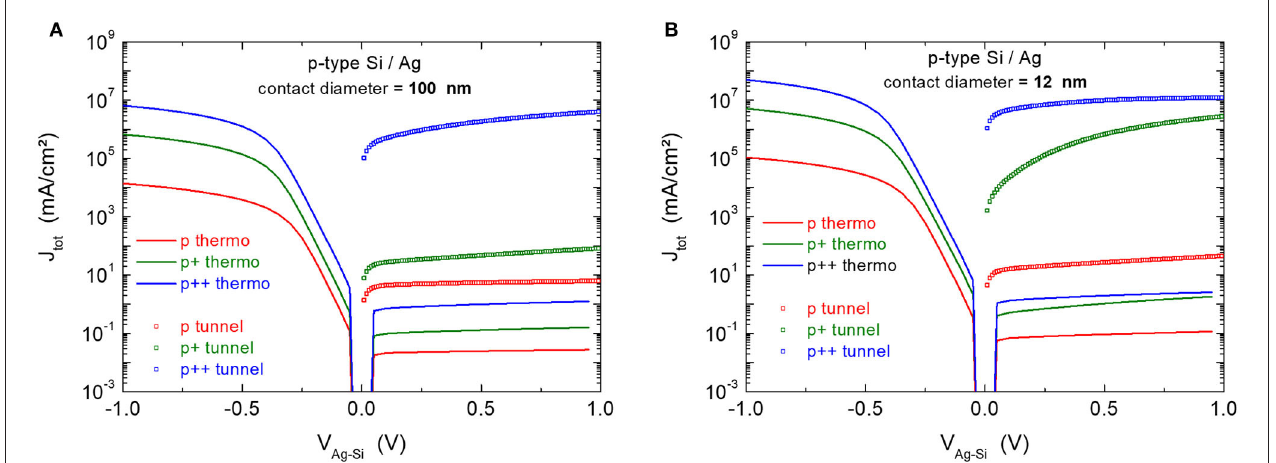
FIGURE 5 | I–V characteristics of p, p + and p ++ silicon in contact with silver (W = 4.64eV). The silver contact diameter is 100nm (A) and 12nm (B) . The current is calculated either for thermionic emission (including image potential effect), and with or without tunneling current